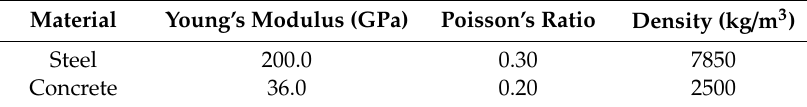
Table 2. Material properties of the steel and concrete.